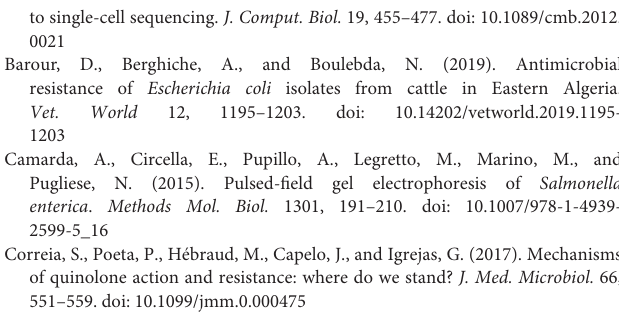
FIGURE S1 | Epidemic curve of the S . Typhimurium outbreak by day of symptom onset. FIGURE S2 | Phylogenetic tree of S . Typhimurium. The branch where the outbreak strains are located was marked in blue color, and 11 of the self-test strains were marked in red color. Reads were mapped to the ASM694v2 reference genome of S . Typhimurium. TABLE S1 | Epidemiological characteristics of 11 incident cases in the outbreak